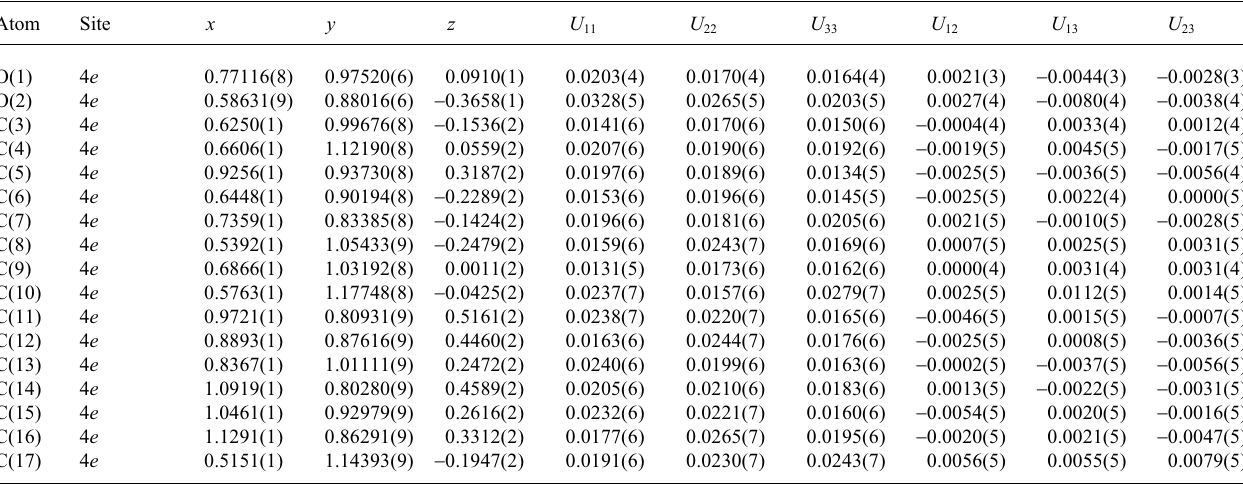
Table 3. Atomic coordinates and displacement parameters (in Å 2 )